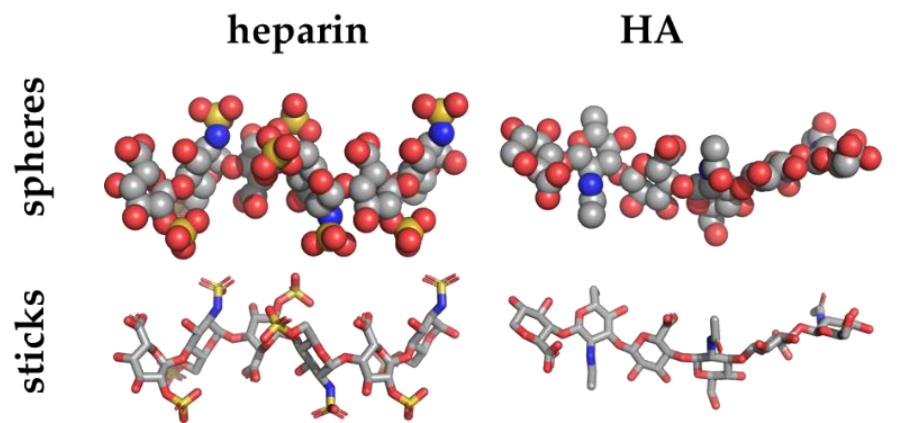
Figure 3. Heparin (PDBid 1HPN) [49] and HA (PDBid 1HYA) [50] crystal structures depicted in sphere and stick representations and colored by elements (carbon, oxygen, nitrogen and sulphur atoms in grey, red, blue and yellow, respectively). Table 2. Web-based tools for computational studies of GAGs. Accession date for all the links reported in the table: April 12, 2021. FF: force field.